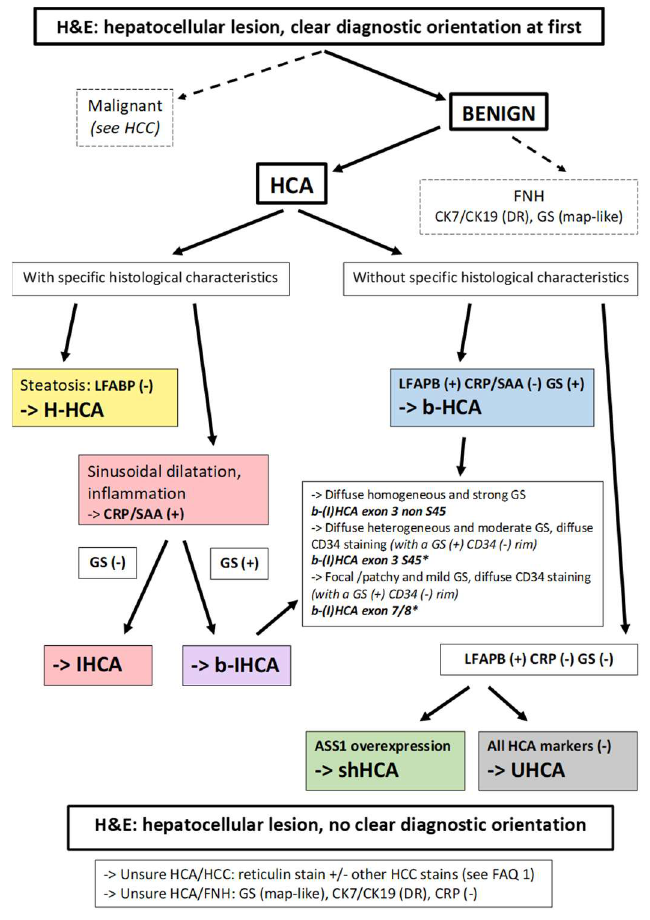
Figure 2. Diagnostic algorithm for HCAs. From a practical point of view, most of the cases are easily recognized as benign or malignant, but some are not. In the situation of an obvious HCA, if there is steatosis, with LFABP (−) and GS (−), there is no need to perform further IHC staining; it can be concluded that the tumor is an H-HCA. If an HCA shows sinusoidal dilatation and inflammation, with LFABP (+) and GS (−), it is mandatory to perform CRP and/or SAA immunostaining in order to diagnose an IHCA. GS immunostaining is mandatory in all IHCAs in order to diagnose a b-IHCA. Different patterns of GS staining exist, linked to the type of underlying mutations (see [2]). If LFABP is positive and all other markers are negative, then an overexpression of ASS1 will lead to the iden- tification of a shHCA, whereas, if it is not overexpressed, it is an UHCA. * Importantly, the GS(+)/CD34(−) rim can be irregular or discontinuous and is usually better represented in b-HCA